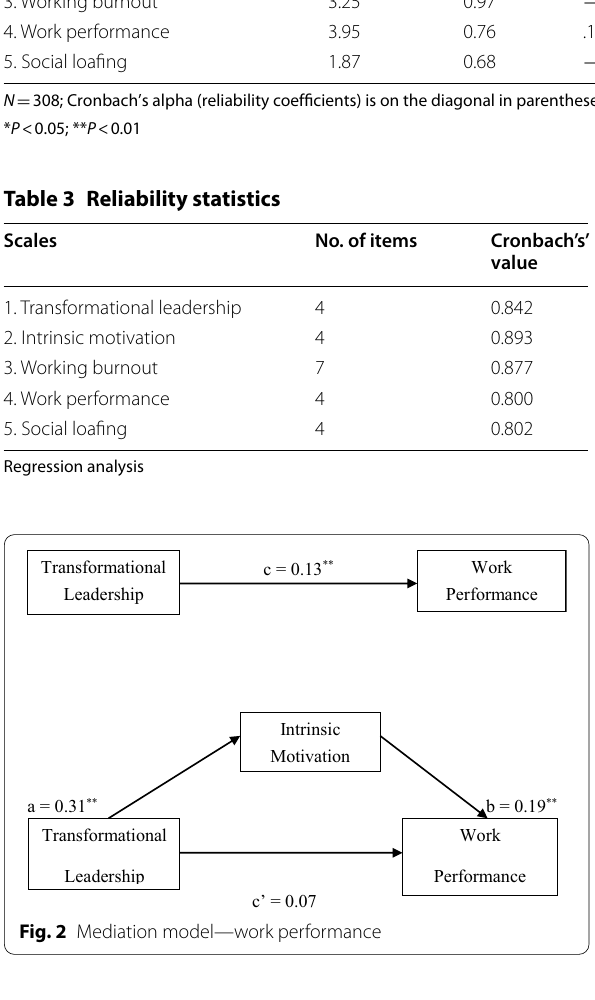
Fig. 2 Mediation model—work